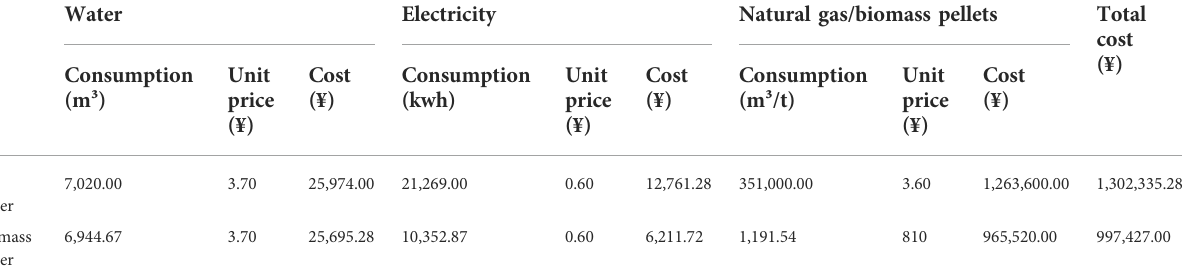
TABLE 9 Material consumption and cost of gas boiler/biomass boiler.